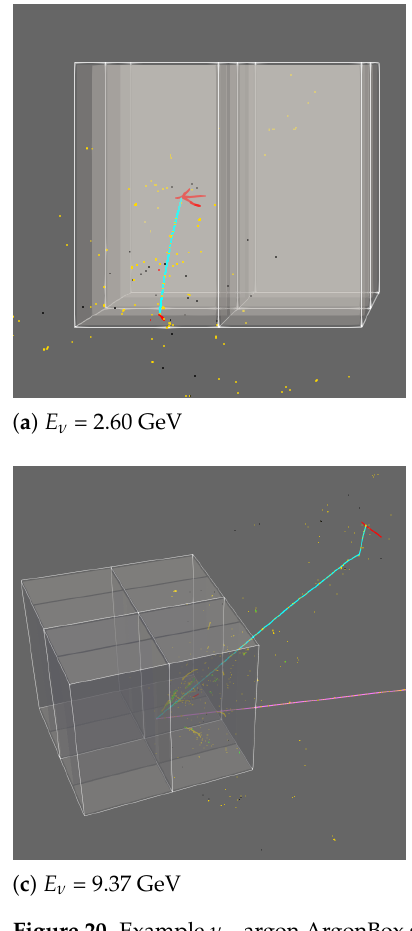
Figure 20. Example ν µ –argon ArgonBox simulated events for a number of different incident neutrino energies, where the energy deposits in a bulk volume of LAr are color-coded according to the particle type: π ± —cyan; µ ± —purple; e + —green; e − —yellow; proton—red; recoiling nuclei—black. The event vertices are randomly placed within the active volume of the 2 2 Demonstrator module, the × geometry for which is superimposed on these images, but which is not simulated by